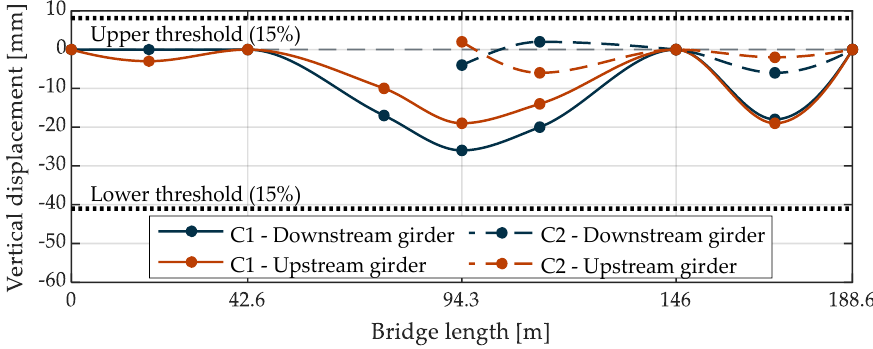
Figure 9. Residual deflections of the deck after the loads removal.